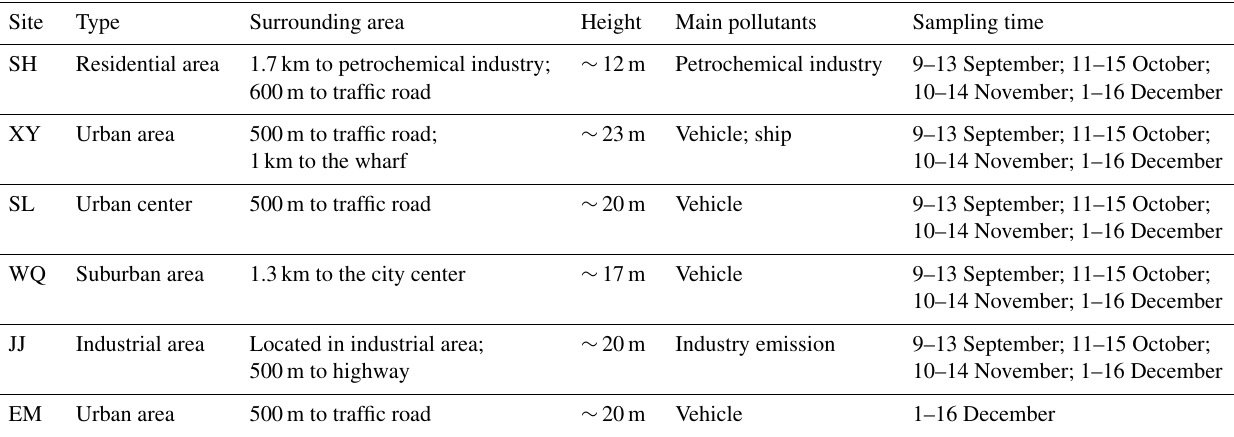
Table 1. Detailed description of the six sampling sites in this